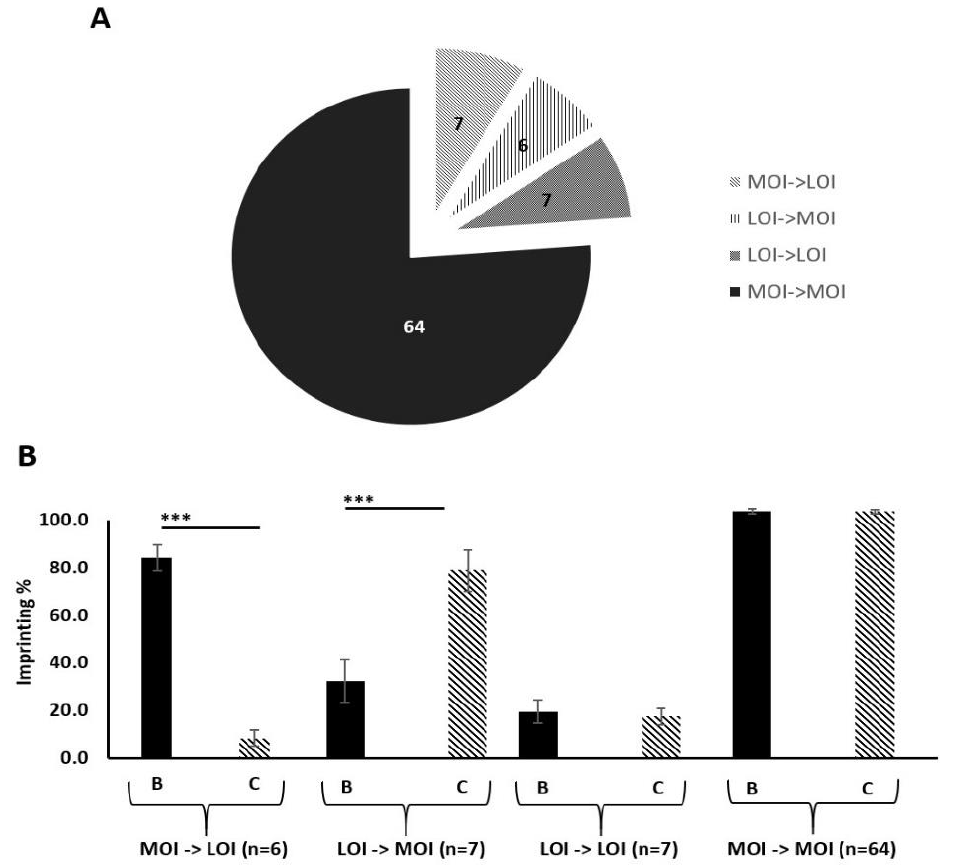
Figure 3. Imprinting status of paired benign and malignant prostate tissue samples from the PrEvENT cohort. ( A ) Cohort divided by imprinting status change, moving from benign to corresponding malignant counterpart. Of the total cohort (84 tissue pairs), 64 showed no change of maintenance of imprinting (MOI) from benign to malignant; 7 showed no change of loss of imprinting (LOI), from benign to malignant; 6 showed a change from LOI to MOI and 7 showed a change from MOI to LOI. ( B ) Imprinting status sub-divisions of PrEvENT cohort, with changes in imprinting percentage. A significant decrease ( p < 0.001) in imprinting percentage was seen in samples where imprinting status changed from MOI to LOI ( n = 7); conversely, a significant increase ( p < 0.001) in imprinting percentage was seen in samples where imprinting status changed from LOI to